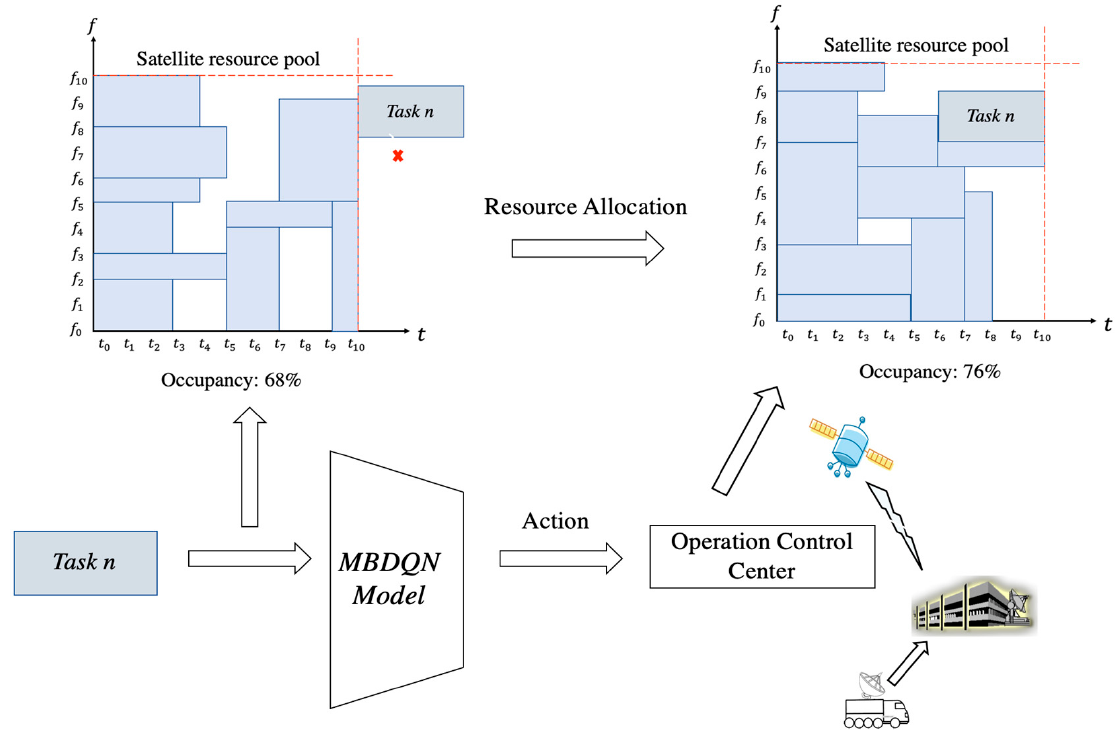
Figure 2. MBDQN is used to conduct efficient satellite resource allocation and improve resource occupancy.